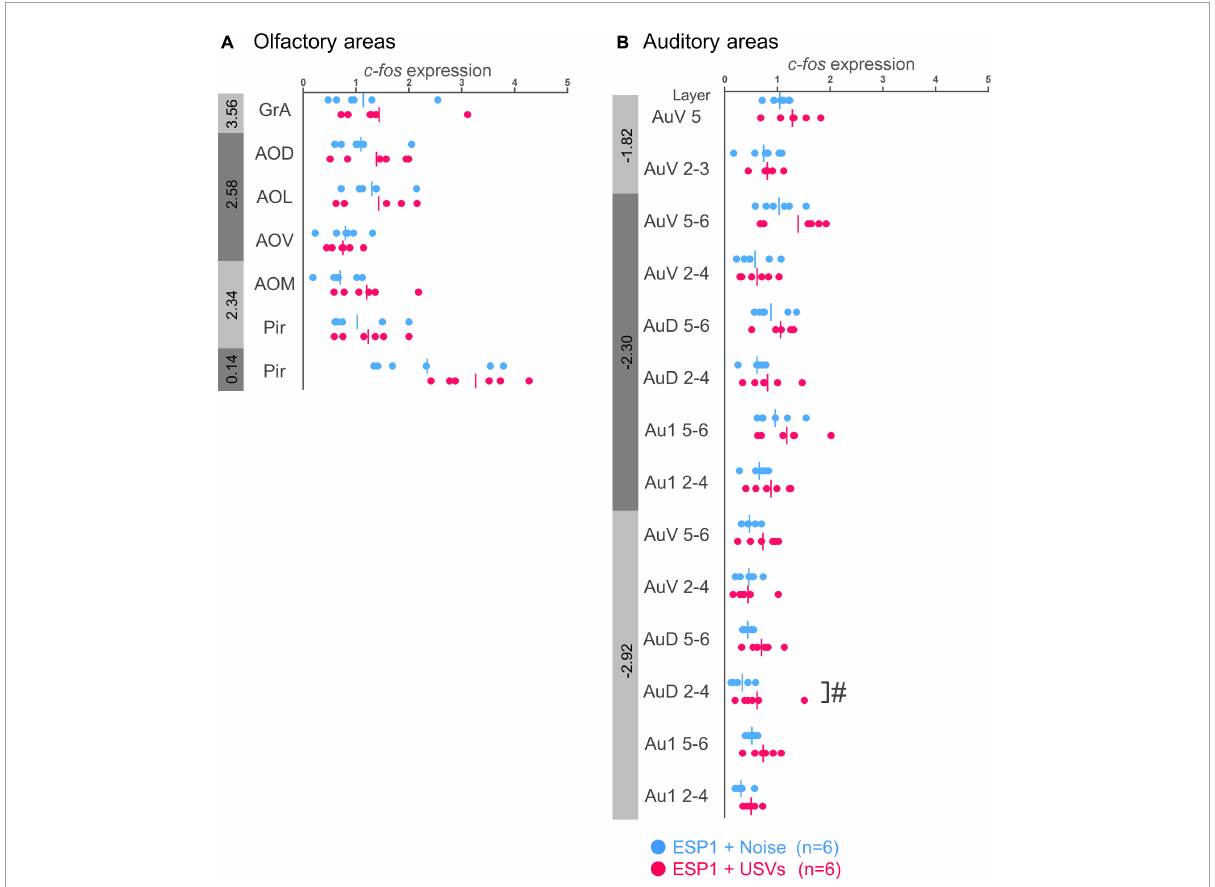
FIGURE1 Expression levels of c-fos mRNA in the olfactory (A) and auditory (B) cortices of female mice. Blue and red symbols represent individual data for ESP1+noise and (exocrine gland-secreting peptide 1) ESP1+USVs (ultrasonic vocalizations) conditions, respectively. Vertical lines indicate mean values. Numbers in gray bands indicate approximate anteroposterior distance to the bregma (mm). # p < 0.05 (Welch’s t -test; but not significant after multiple comparisons correction). GrA, granule cell layer of the accessory olfactory bulb; AOD, anterior olfactory area, dorsal part; AOL, anterior olfactory area, lateral part; AOV, anterior olfactory area, ventral part; AOM, anterior olfactory area, medial part; Pir, piriform cortex; AuV, secondary auditory cortex, ventral area; AuD, secondary auditory cortex, dorsal area; Au1, primary auditory